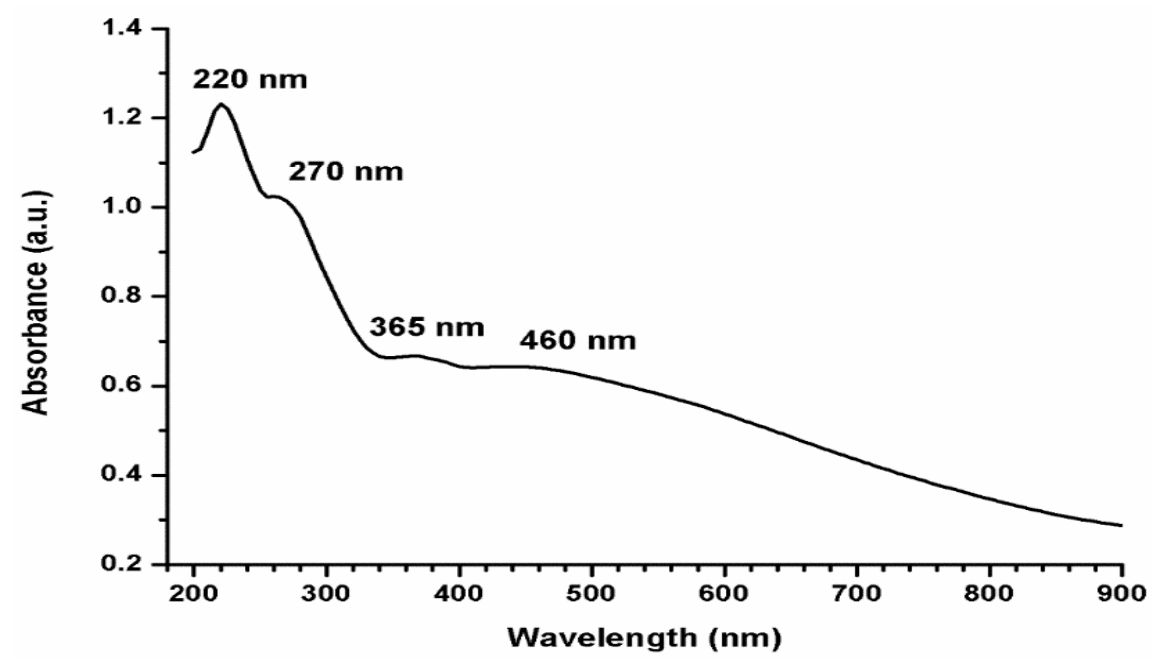
Figure 1. UV–Vis spectrum of AgNPs prepared by pomegranate peel extract in the wavelength range of 200–900 nm.